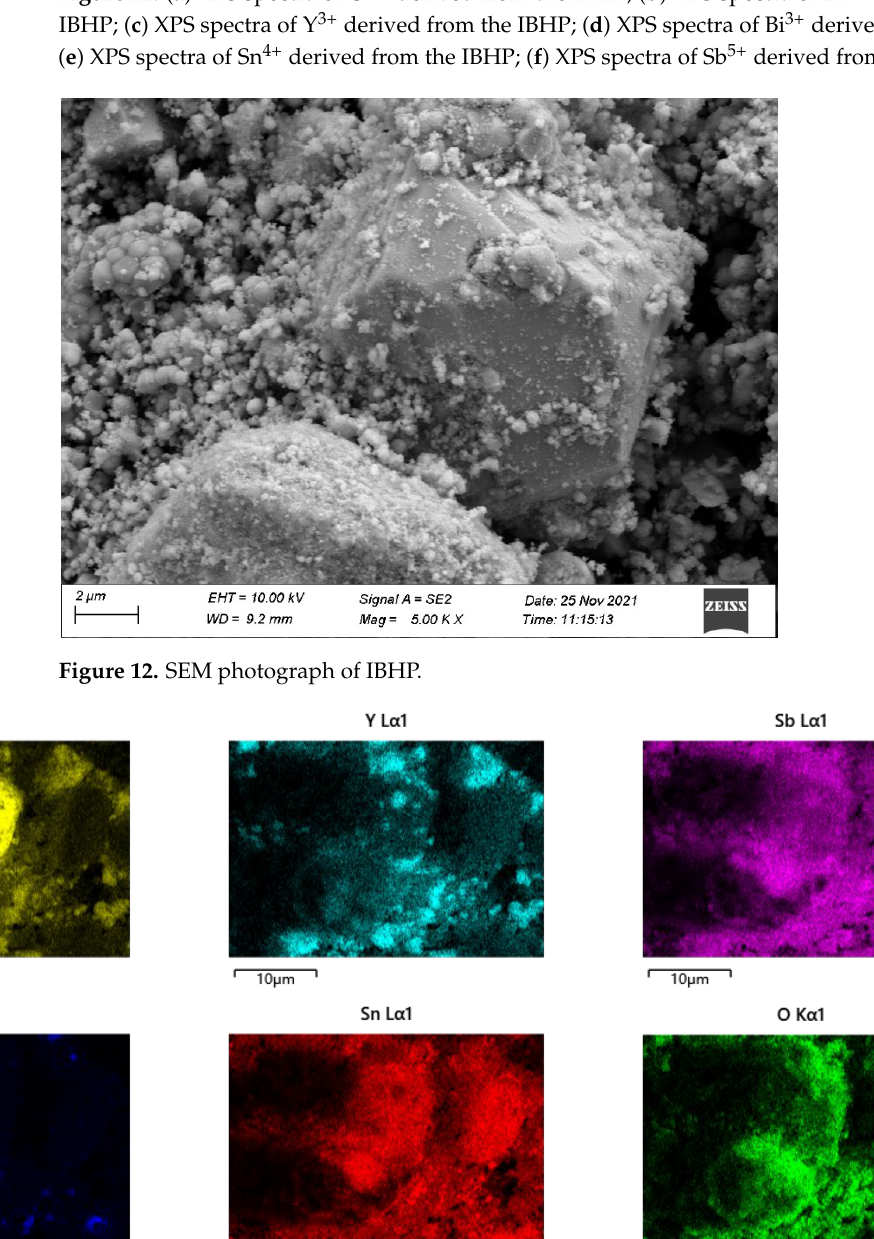
Figure 13. EDS elemental mapping of IBHP (In, Y, Sb, O from In 2 YSbO 7 and Bi, Sn, Sb, O from BiSnSbO 6 ).